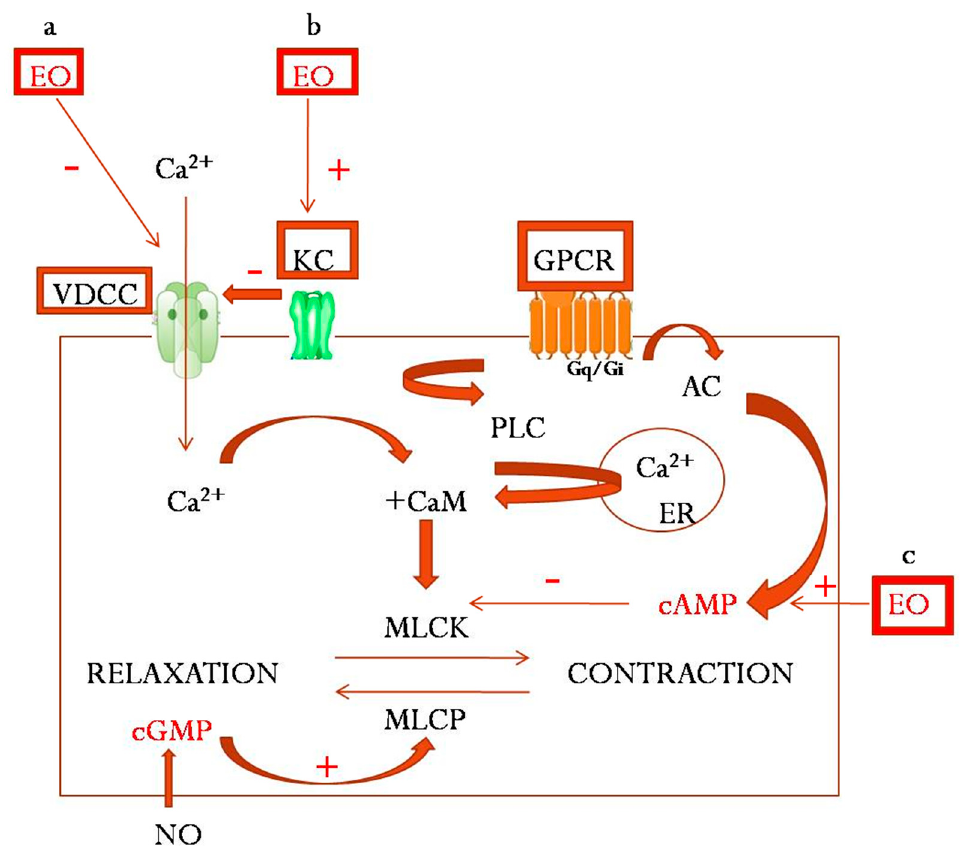
Figure 1. Main mechanisms of antispasmodic e ff ect of essential oils: a. inhibition of voltage-dependent calcium channels; b. modulation of potassium channels; c. modulation of intracellular cAMP (EO—essential oil, VDCC—voltage-dependent calcium channel; KC—potasium channel, GPCR—G-protein coupled receptors, CaM—calmoduline, PLC—phospholipase C, AC—adenylyl cyclase, MLCK—myosin-light chain kinase, MLCP—myosin-light chain phosphatase, ER—endoplasmic reticulum, cGMP—cyclic guanosine monophosphate, cAMP—cyclic adenosine monophosphate, NO—nitric